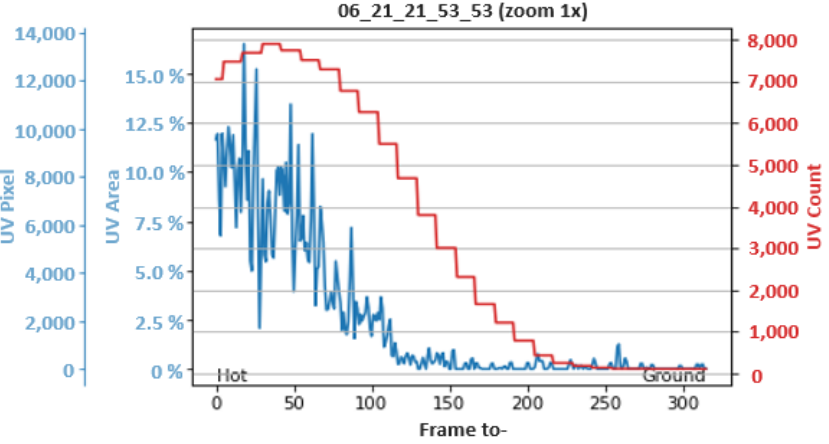
Figure 5. UV quantitative parameters for insulator string: phase suspension string at the GIS area.